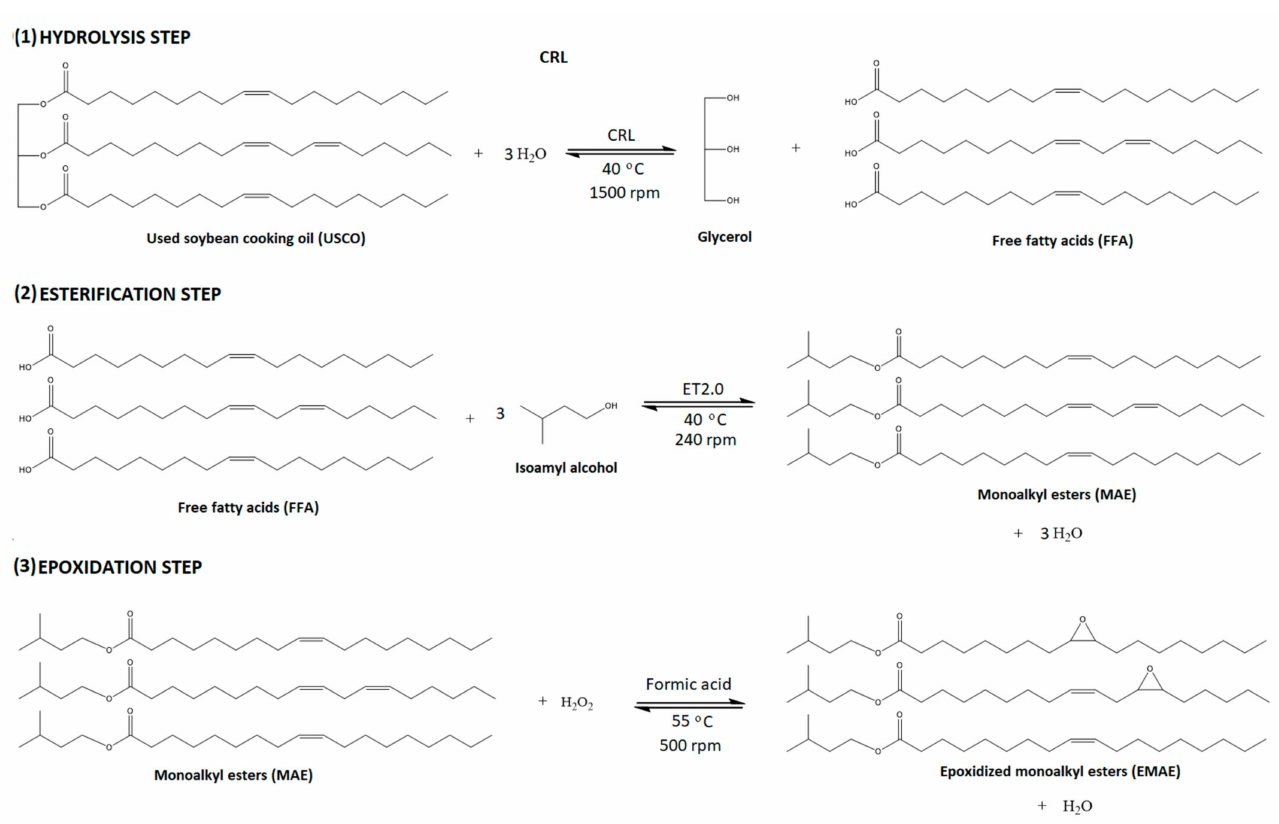
Figure 4. 1 H NMR spectra of fusel oil, used soybean cooking oil (USCO) and their derivatives—free fatty acids (FFA), monoalkyl esters (MAE) and epoxidized monoalkyl esters (EMAE).